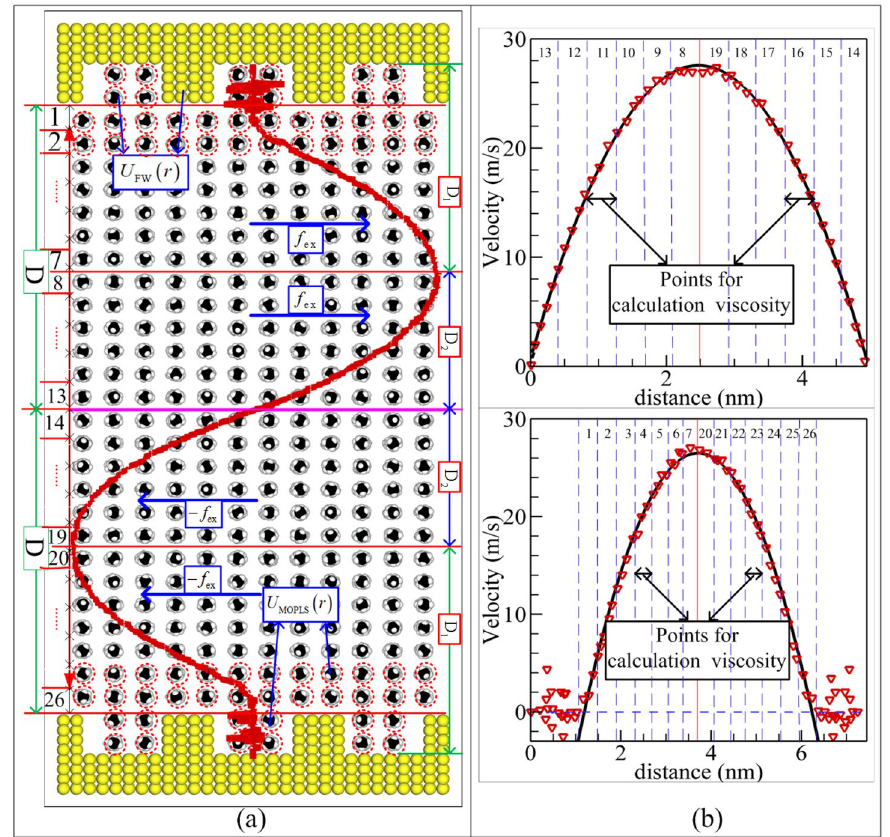
Figure 1. Schematic representations of the mixture boundary Poiseuille flow model ( a ) and the fitted local velocity profile method ( b ). Comparison of the velocity profile of nonslip boundary (top) and that of rough surface (bottom) obtain from one time NEMSMD simulation at given state points ( b ) 377.15 kg/m 3 , T 140 K ( ρ = =